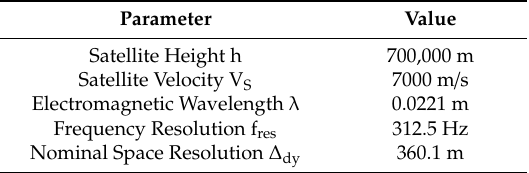
Table 1. Main parameters of CryoSat-2 altimeter in DDA mode.